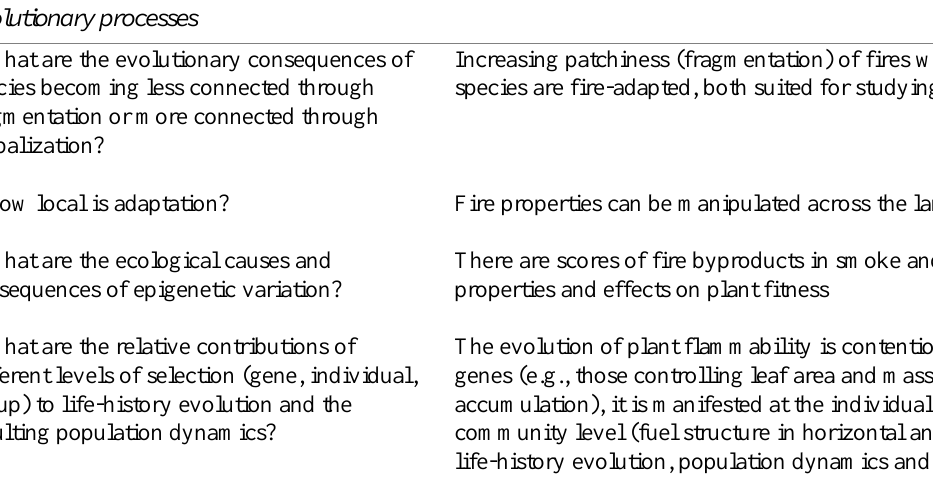
Table A3. Fifty-five of the 100 ‘fundamental’ questions for ecology selected by Sutherland et al. (2013) that we show fire considerations help to address. The original numbers of the questions have been retained. We have made no attempt to review the relevant literature but simply use the cited papers to illustrate how many of the questions have already been